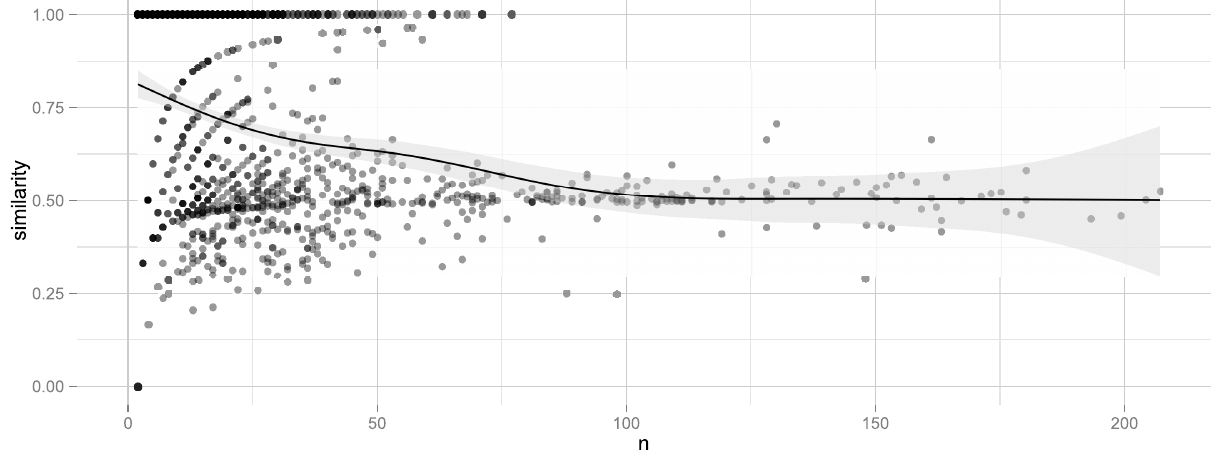
Fig 7. Proportion of pairs of students making the same educational choice with respect to class